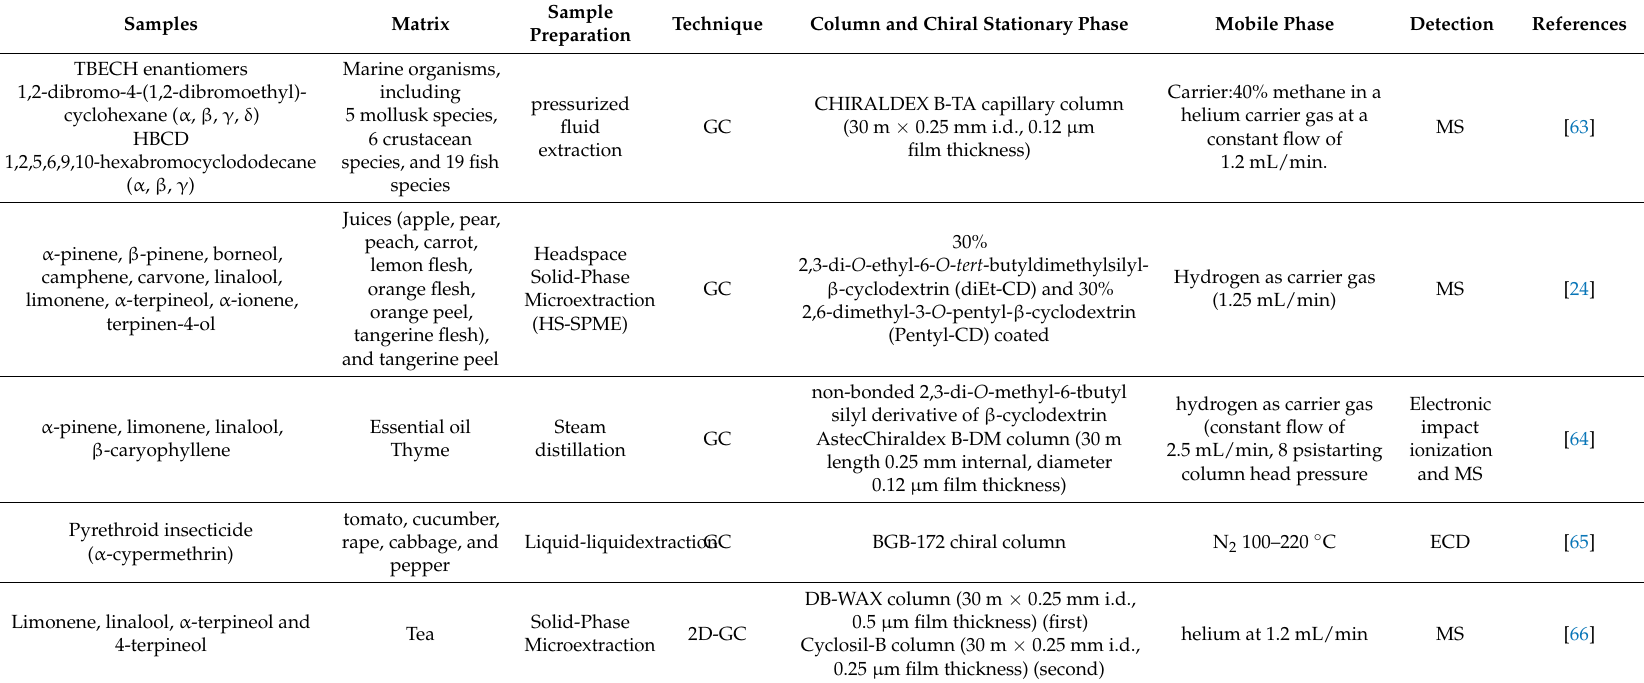
Table 3. Selected applications of GC to Food